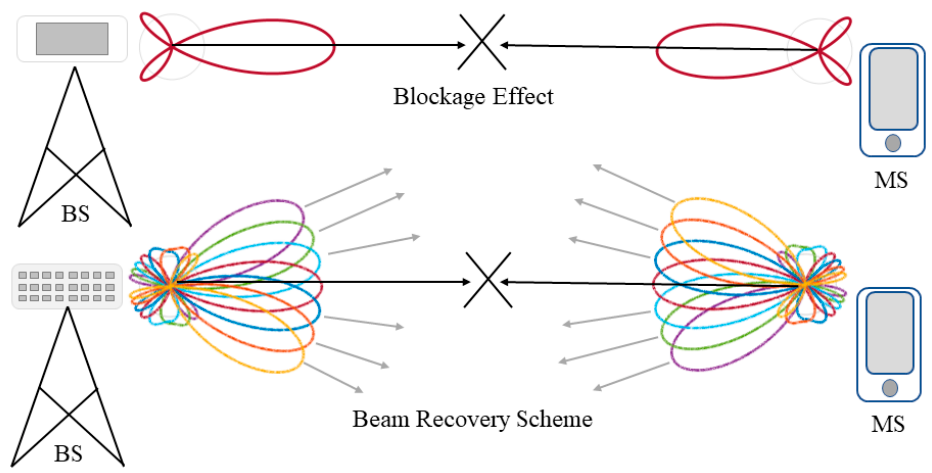
Figure 3. Proposed multi-backup beam recovery scheme.